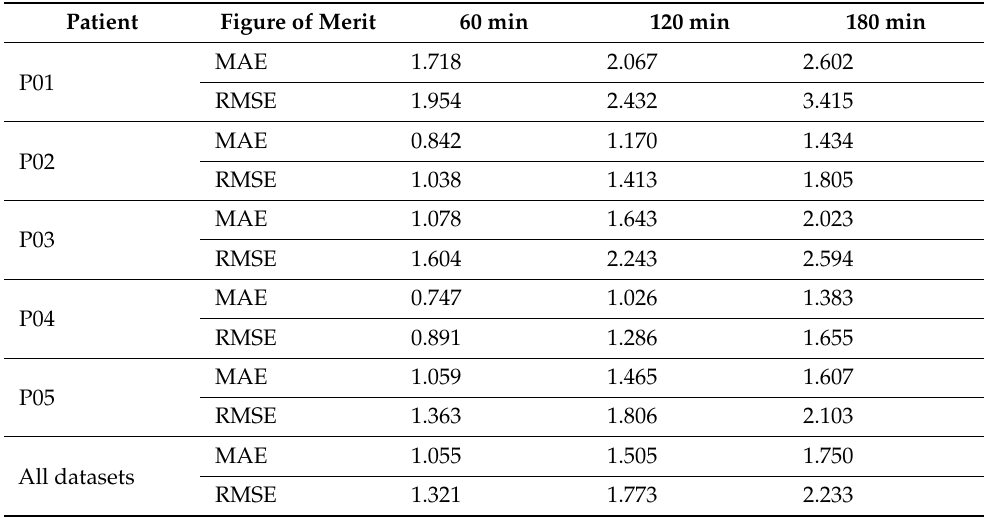
Table 6. RMSE and MAE results with the DFB version on four horizons, all values in mmol/L. Patient